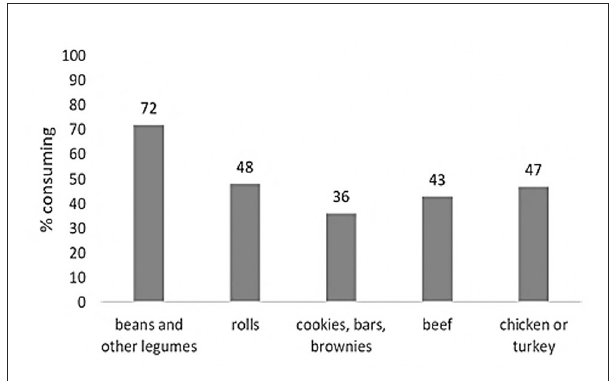
FIGURE1 Percentage of Brazilian children aged 4–8 years who consume the five main dietary sources of iron.